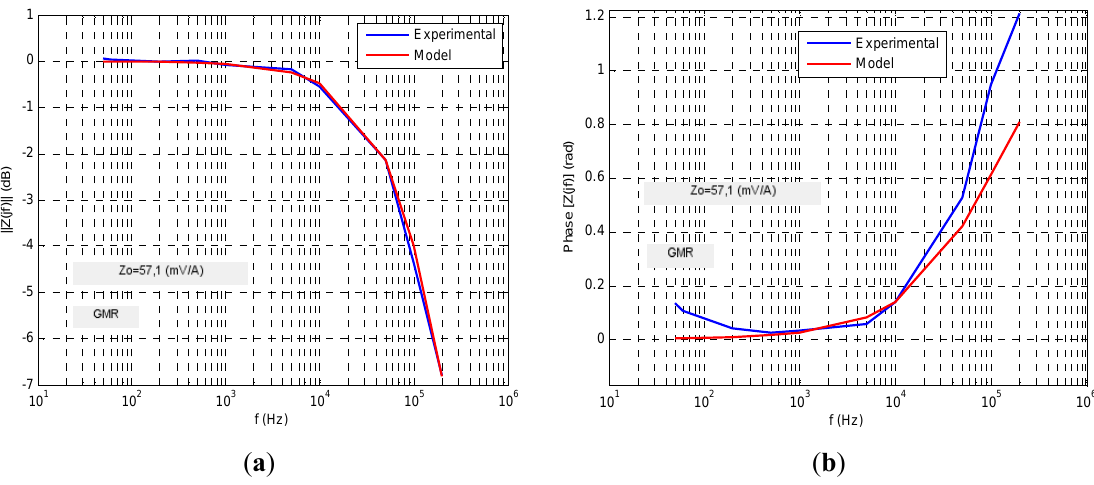
Figure 11. GMR sensor ac large-signal fractional modeling.